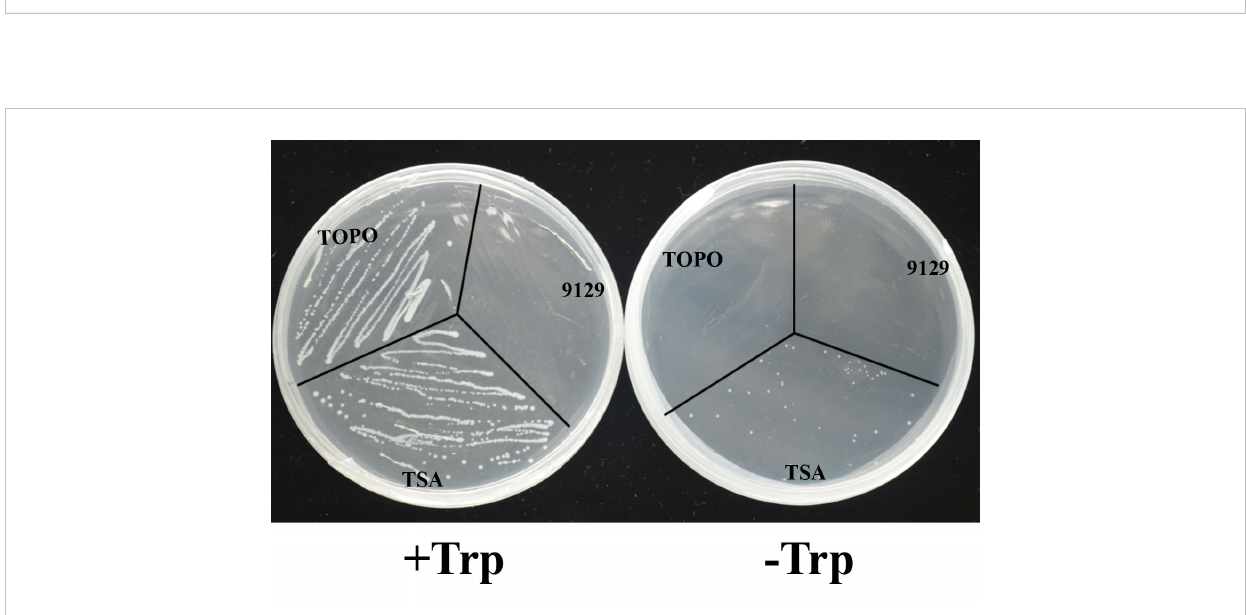
FIGURE 5 Complementation of E.coli △ trpA mutant with the BcTSA cDNA. (9129) E.coli △ trpA mutant. (TOPO) transformant containing the pBAD-TOPO vector. (TSA) transformant containing the BcTSA ORF in the pBAD-TOPO vector.